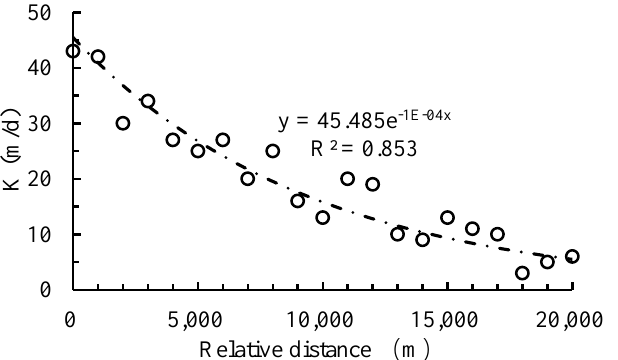
Figure 2. Variation of hydraulic conductivity along the distance from apex to apron zone in the Tailan river basin.